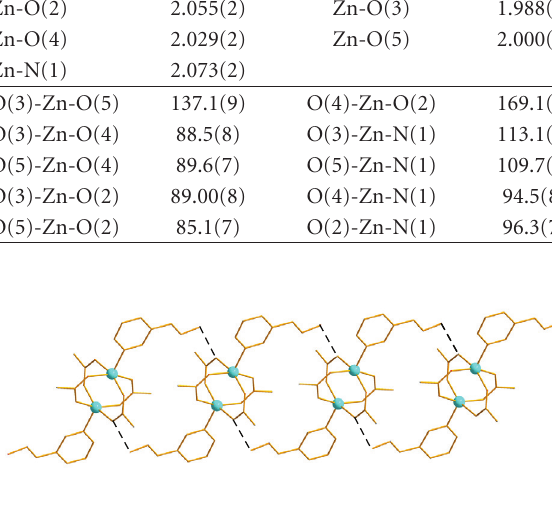
Figure 4: A small portion of the ladder-like 1D architectures of 2 due to H-bonding interactions (black dashed lines). The H atoms have been omitted for